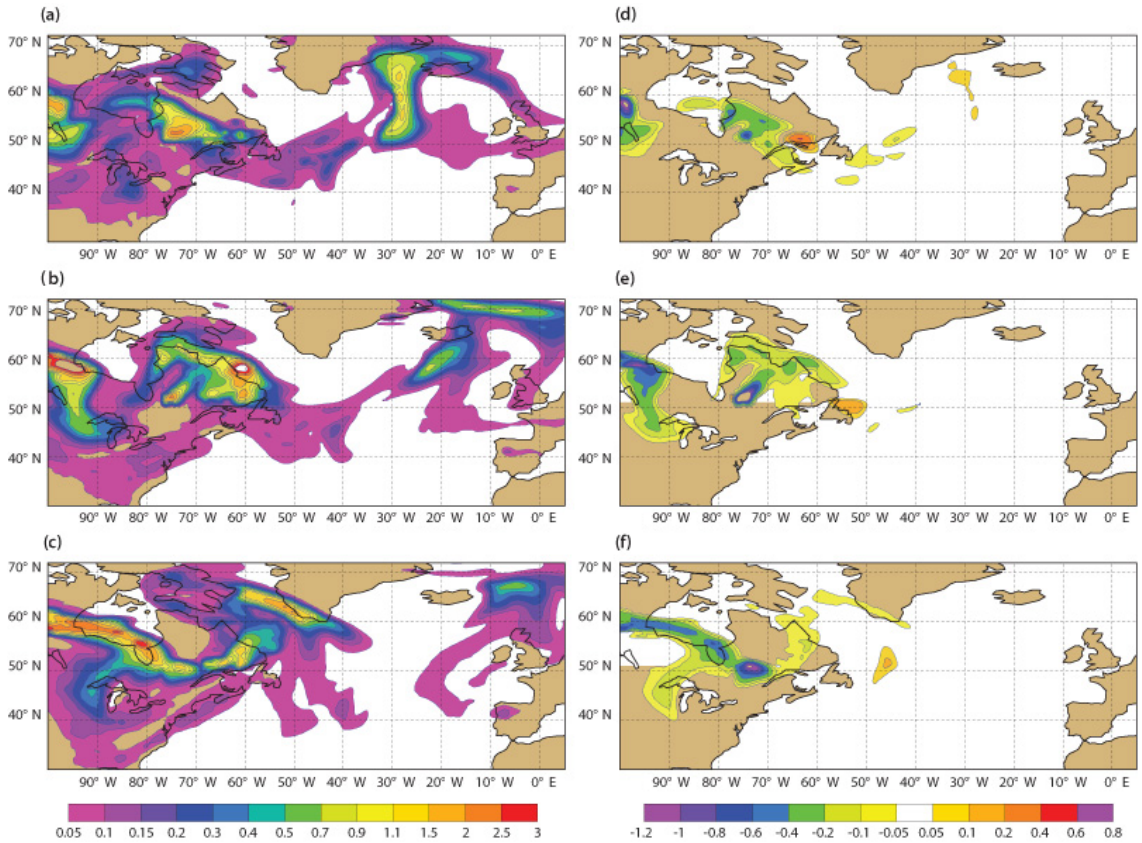
Figure 4. Panels (a–c) show aerosol optical depth (AOD) at 550nm for the IFS forecast starting on 10 July 2013 and with lead times of 3h (a) , 24h (b) and 48h (c) using the operational GFAS with the observation operator equal to persistence. Panels (d–f) show the difference in AOD between the two methods using the classical GFAS–persistence and the GFAS–FWI observation operator; (d) 3h, (e) 24h and (f) 48h.